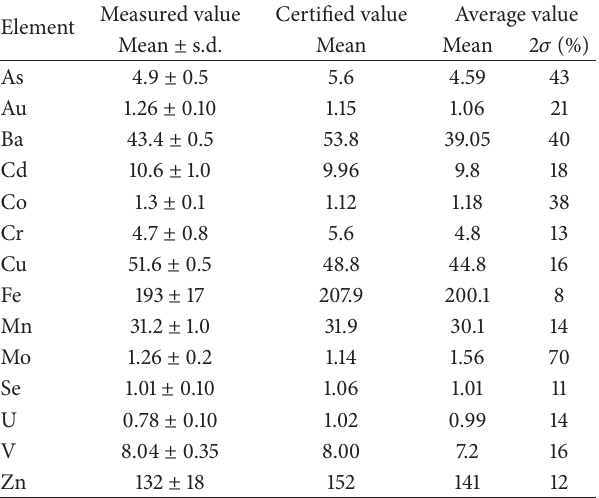
Table 2: Results of INAA quality control on IAEA air filter samples ( 𝜇 gg − 1 ). The “measured value” is the average of seven determina- tions on seven different replicates. s.d.: standard deviation; n.d.: not